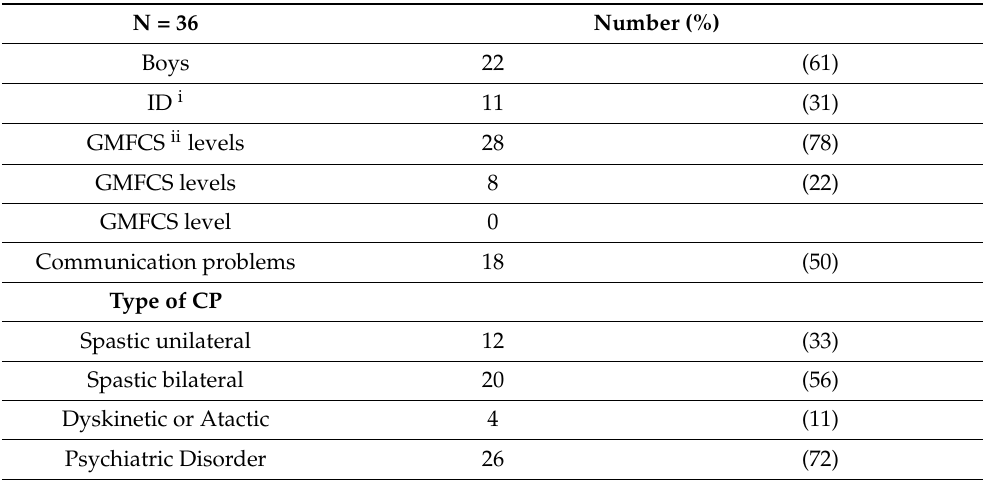
Table 1. Descriptive characteristics for the cohort of children with CP assessed for mental health problems at ages seven and eleven.